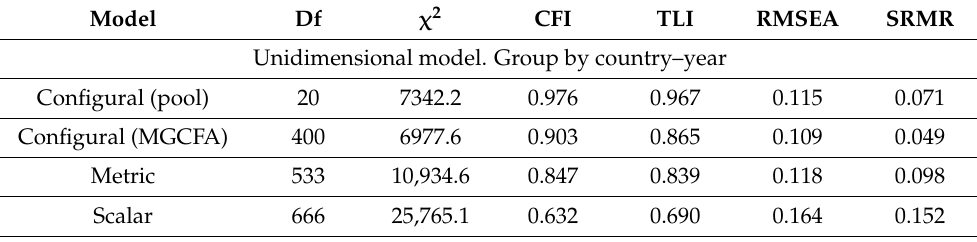
Table 3. Fit indices that test the configural (pool and multi-group), metric, and scalar equivalence. Model Df χ 2 CFI TLI RMSEA SRMR Unidimensional model. Group by country–year Configural (pool) 20